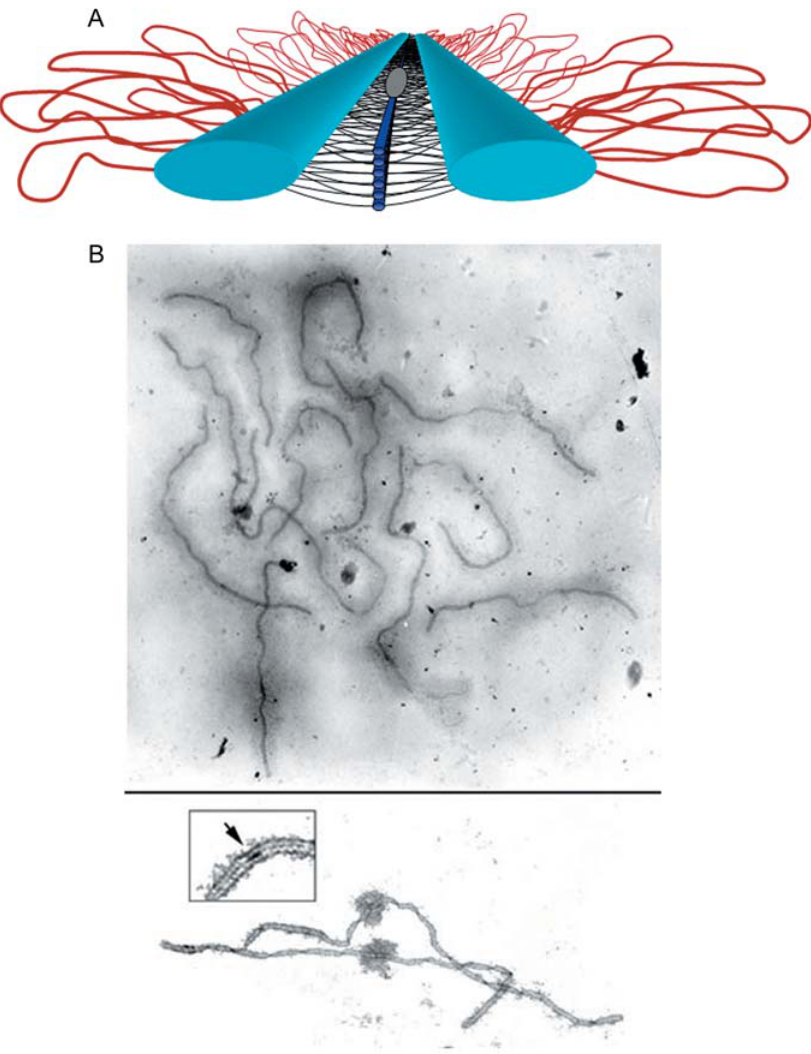
Figure 2. The Synaptonemal Complex (A) Model of the SC. Lateral elements (light blue rods) of homologous chromosomes align and synapse together via a meshwork of transverse fi laments (black lines) and longitudinal fi laments (dark blue rods). The longitudinal fi laments are collectively referred to as the “central element” of the SC. Ellipsoidal structures called recombination nodules (gray ellipsoid) are constructed on the central region of the SC. As their name implies, recombination nodules are believed to be involved in facilitating meiotic recombination (crossing over). The chromatin (red loops) of each homologue is attached to its corresponding lateral element. Because there are two “sister chromatids” in each homologue, two loops are shown extending laterally from each point along a lateral element. (B) Top: Set of tomato SCs. Chromatin “sheaths” are visible around each SC. Bottom: Two tomato SCs. The chromatin has been stripped from the SCs, allowing the details of the SC to be observed. Each SC has a kinetochore (“ball-like” structure) at its centromere. Recombination nodules, ellipsoidal structures found on the central regions of SCs, mark the sites of crossover events (see inset). Images and legend courtesy of Daniel G. Peterson, Mississippi Genome Exploration Laboratory, Mississippi State University, Mississippi State, Mississippi, United